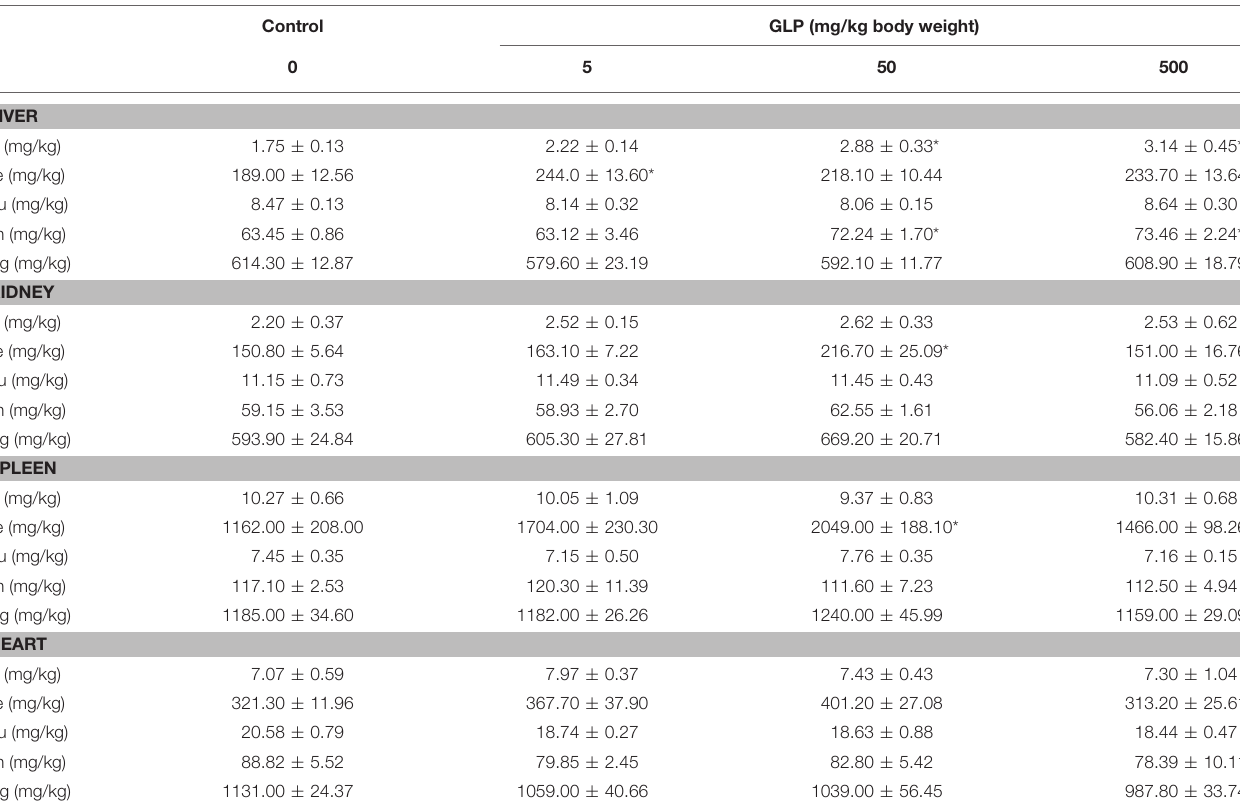
TABLE 4 | The concentrations of Al, Fe, Cu, Zn, and Mg in the liver, kidney, spleen, and heart of rats.